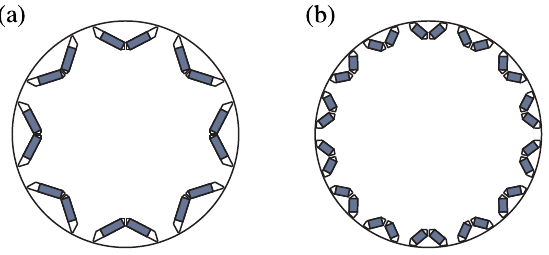
Figure 14. Rotor geometries (shaft excluded) for: ( a ) p = 8, α p = 3/4, h m = 5 mm, w m = 14.2 mm; ( b ) p = 14, α p = 3/4, h m = 5 mm, w m = 8.1 mm. Table 1. p m (W/cm 3 ) for l m = 10 mm at 9000 rpm. Table 2. p m [W/cm 3 ] for l m = 30 mm at 9000 rpm Q s \ p